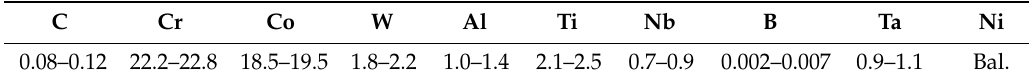
Table 1. Chemistry (wt.%) of the GTD222